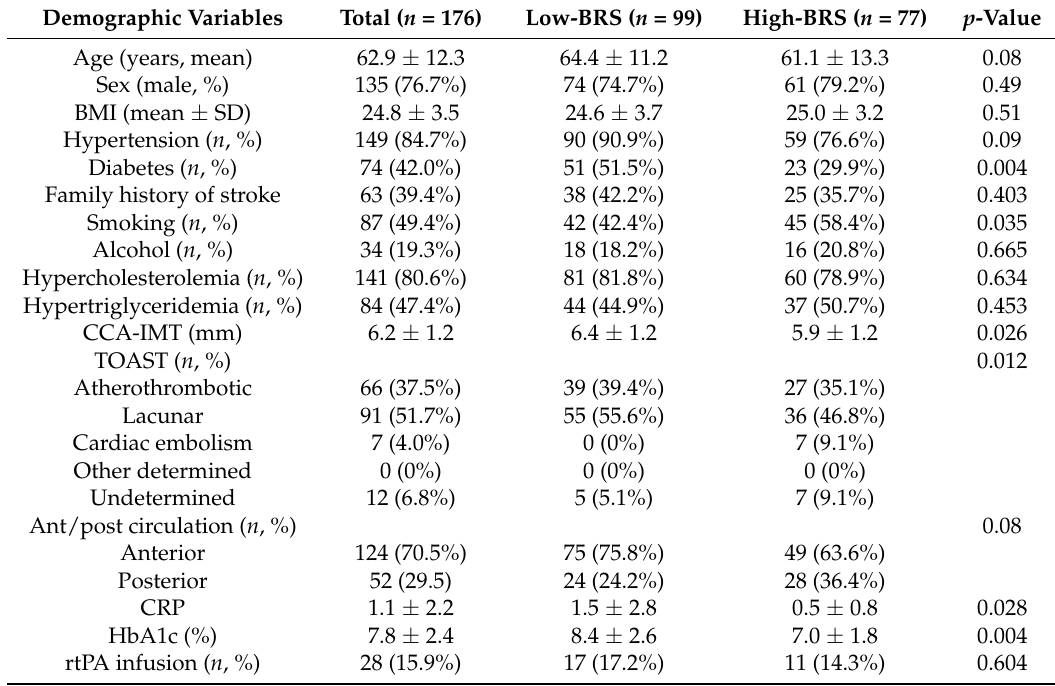
Table 1. Baseline characteristics of all patients and low- and high-BRS